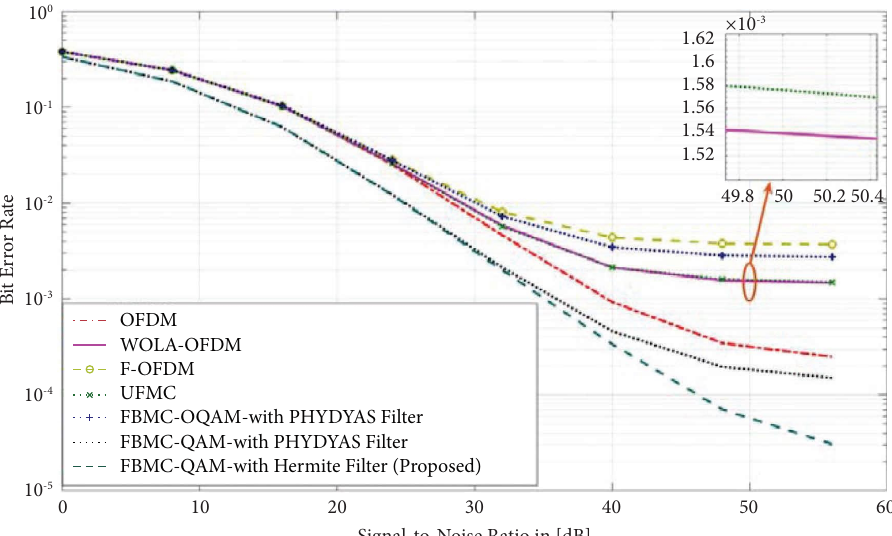
Figure 15: Bit error rate performance of diferent multicarrier modulation techniques for Pedestrian B channel model at 64